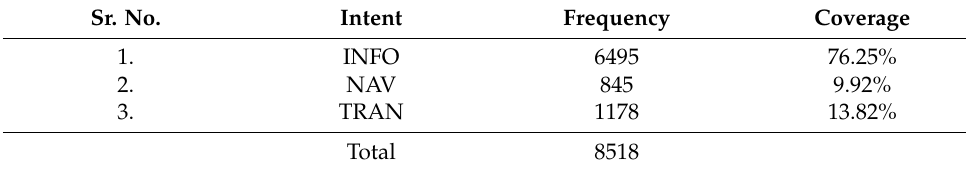
Table 4. Intent distribution in Urdu web queries